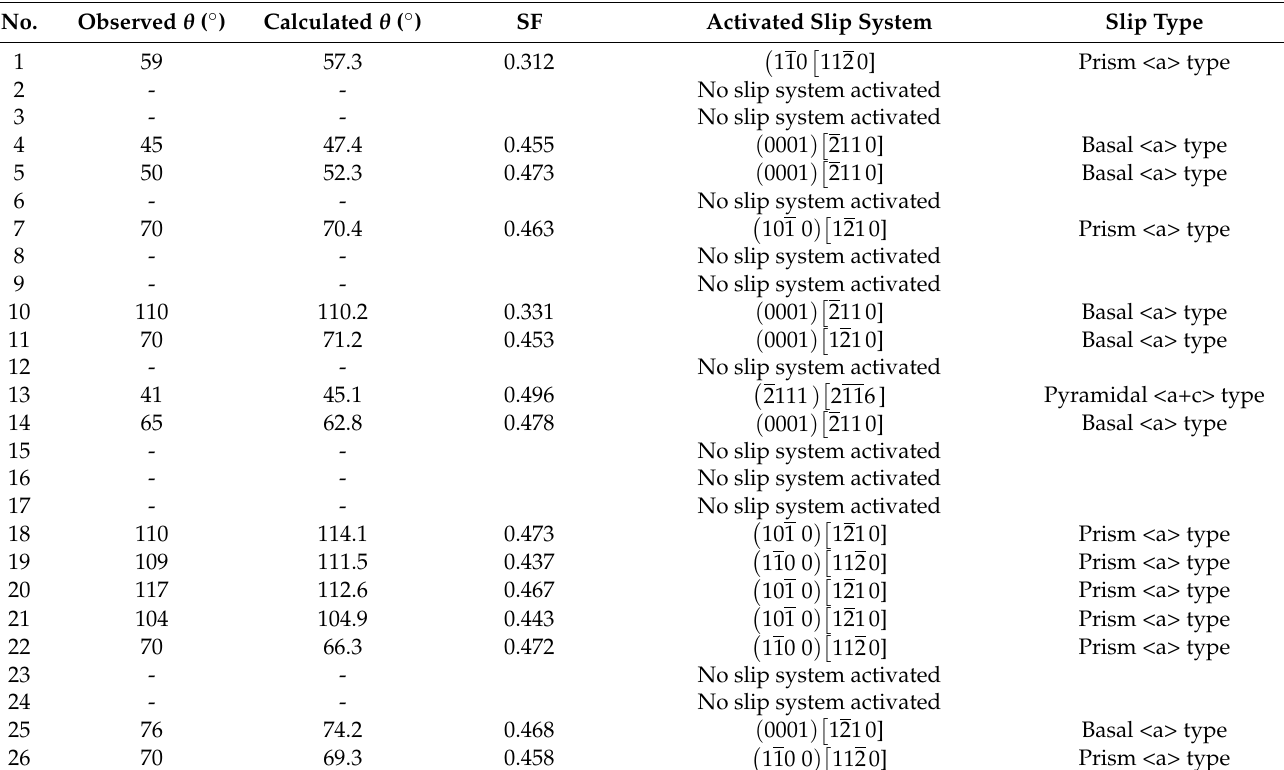
Table 3. The activated slip system of α 2 particles in the